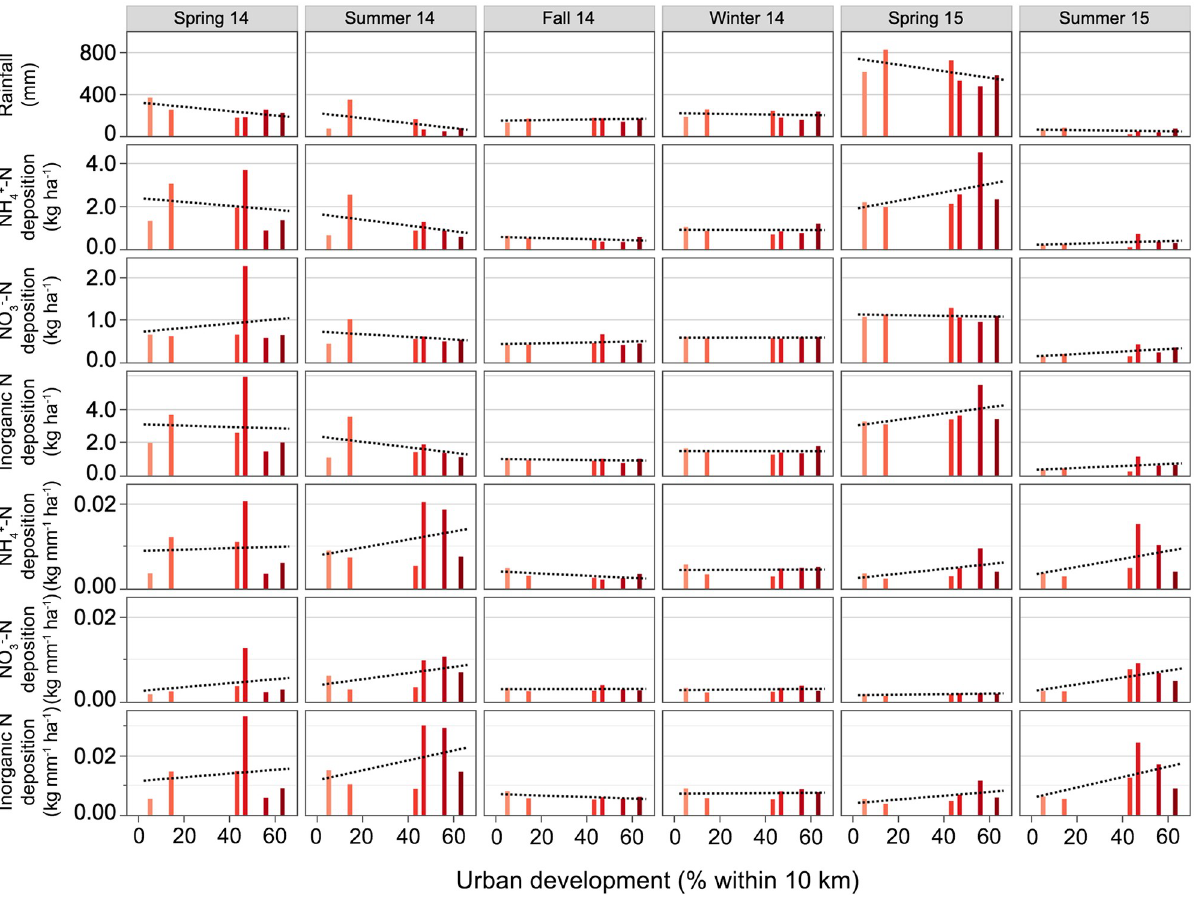
Fig 2. Relationships between urban development, rainfall, and absolute and precipitation-normalized bulk nitrogen deposition for six consecutive sampling seasons. Nitrogen deposition was sampled in Spring 2014 (Apr-Jun), Summer 2014 (Jul-Sep), Fall 2014 (Oct-Dec), Winter